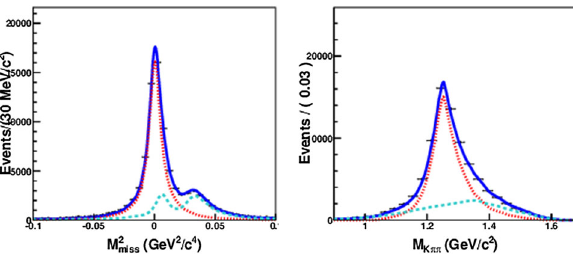
Fig. 2 a The M 2 vs. M K ππ distribution of semi-leptonic candidate events. b , c the M 2 miss events, where the red part denotes the signal events and other parts denote the remaining background events (cid:2)